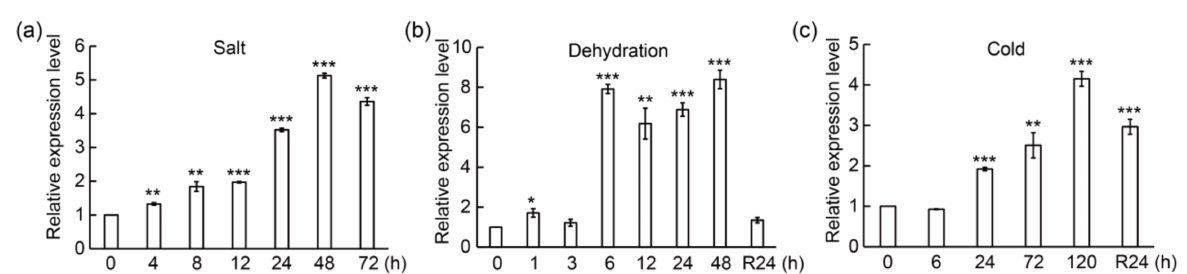
Figure 2. Relative expression levels of PtrMYB3 under salt ( a ), dehydration ( b ) and cold ( c ) stresses at each designated time point. Error bars indicate ± SE (standard error). R: recovery. Asterisks indicate significant differences compared to the value at 0 h: p < 0.05 (*), p < 0.01 (**) and p < 0.001